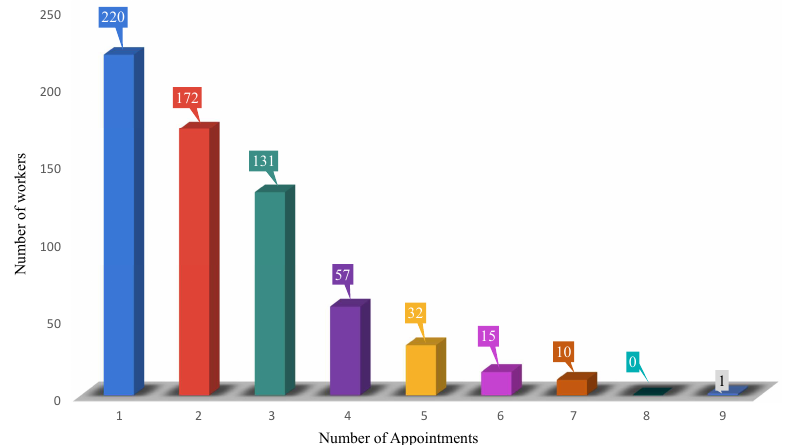
Figure 2. Medical appointment distribution based on the number of workers.